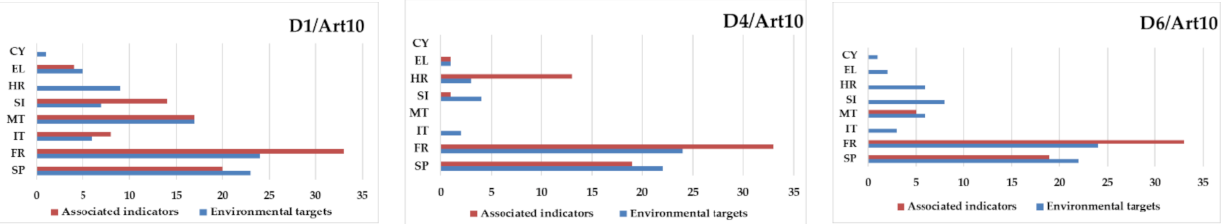
Figure 7. Environmental targets and associated indicators for biodiversity descriptors established by Mediterranean MSs in